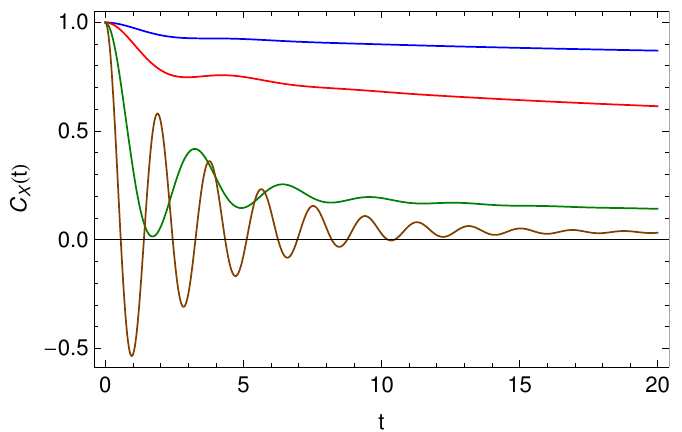
Figure 3. Graphical representation of the normalized displacement correlation function, Equation (46), for γ µ , ρ , δ = 1, τ = 1, ρ = 1/5 µ = 1/2, δ = 3/4, and ω = 0.25 (blue line), ω = 0.5 (red line), ω = 1.44 (green line), ω = 3 (brown line).